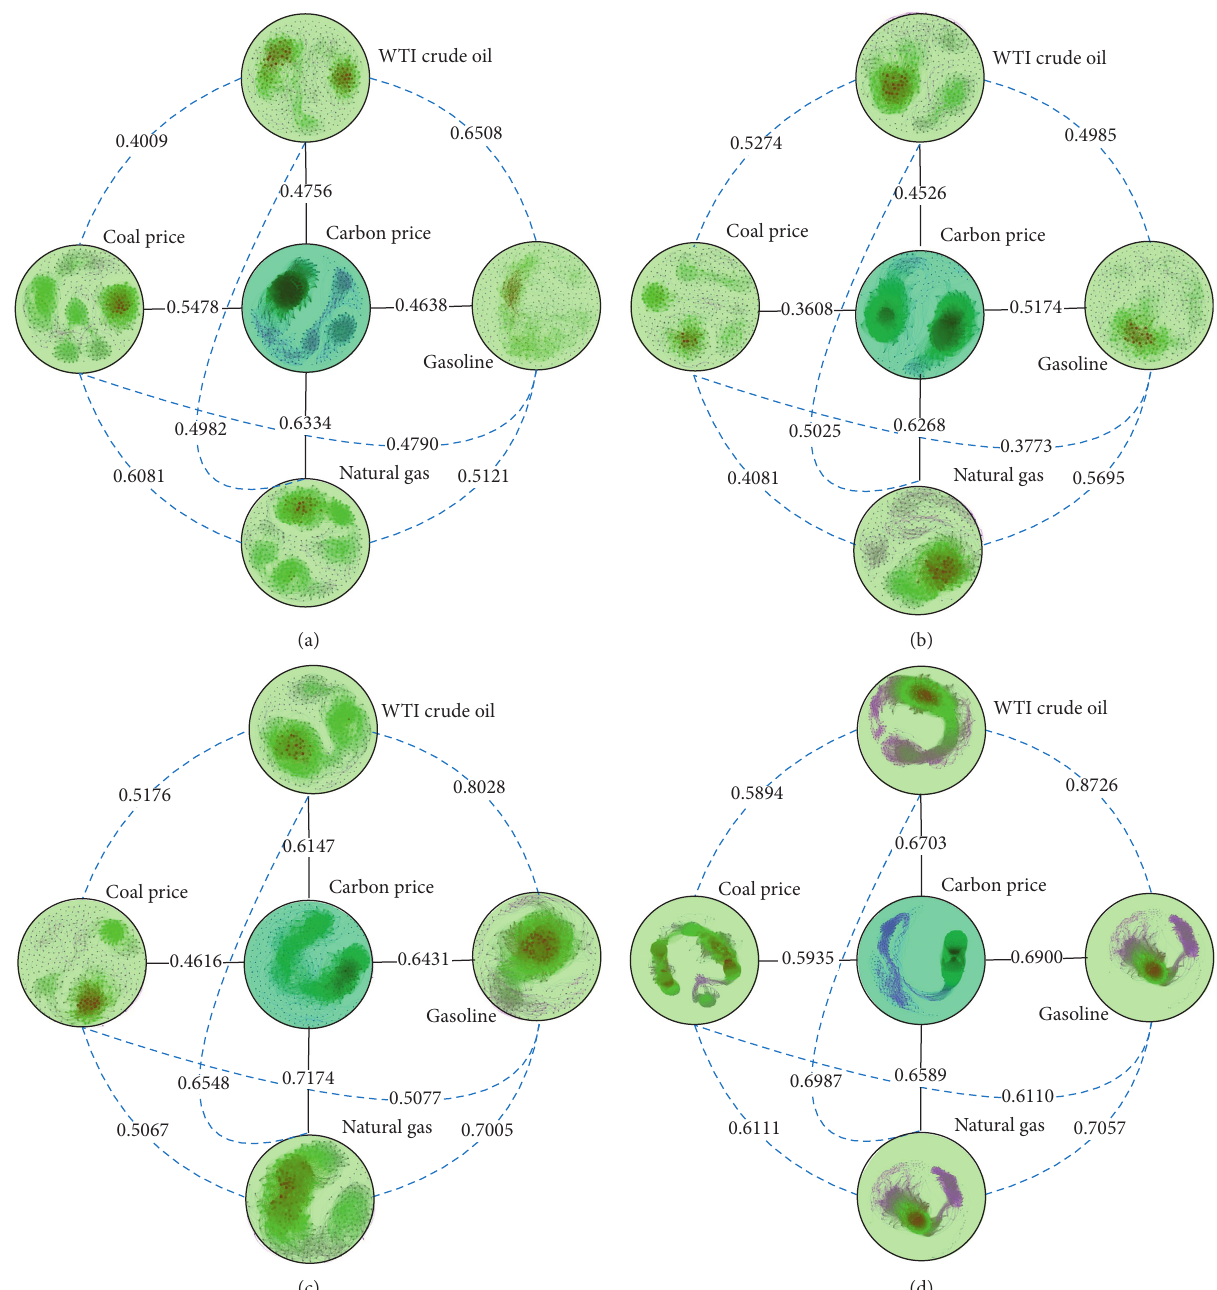
Figure 5: Linkage between carbon and energy prices: (a) second stage, (b) transition from second to third stage, (c) initial stage of third stage, and (d) current